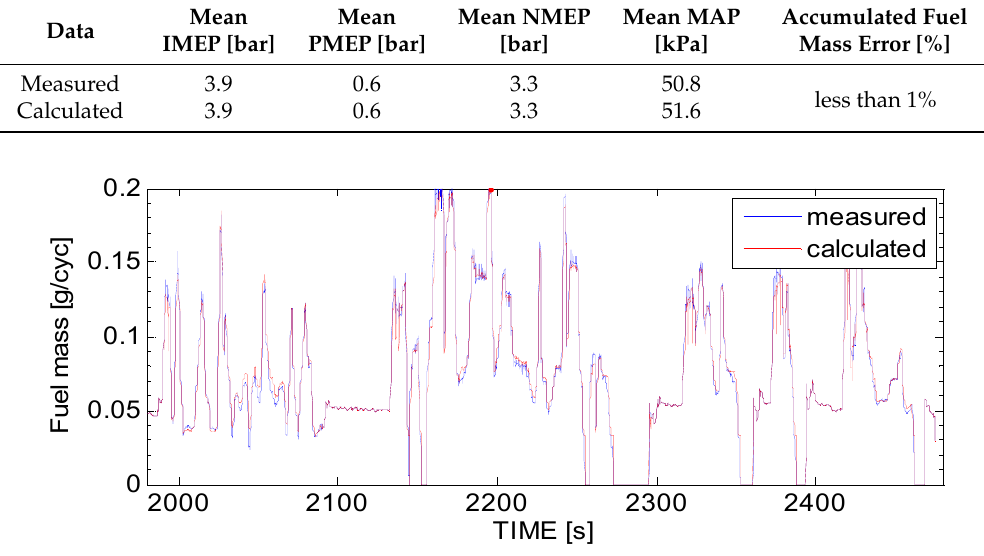
Figure 3. Comparison between measured and calculated fuel rate of vehicle 3 in phase 3 of FTP-75.